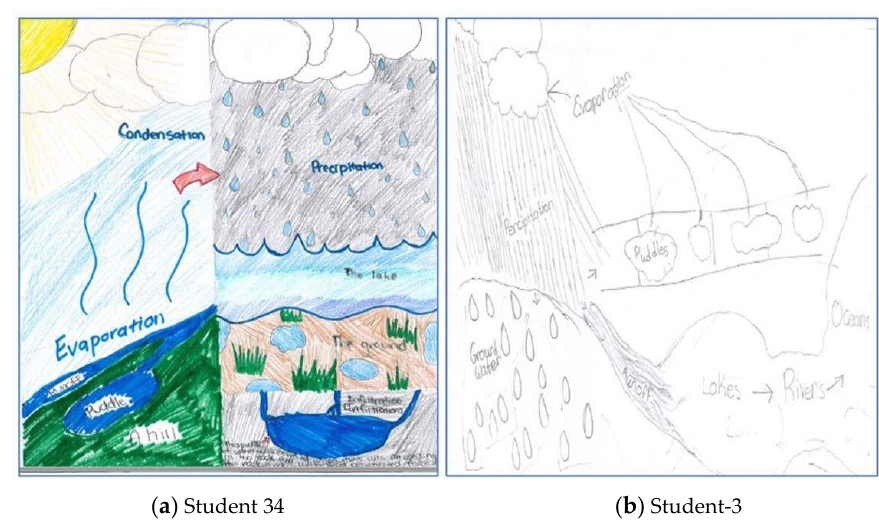
Figure 4. Post-Drawing Assessments from two different study participants, one in class #1 ( a ) and the other in class #2 ( b ) that highlight the inclusion of subsurface interactions.